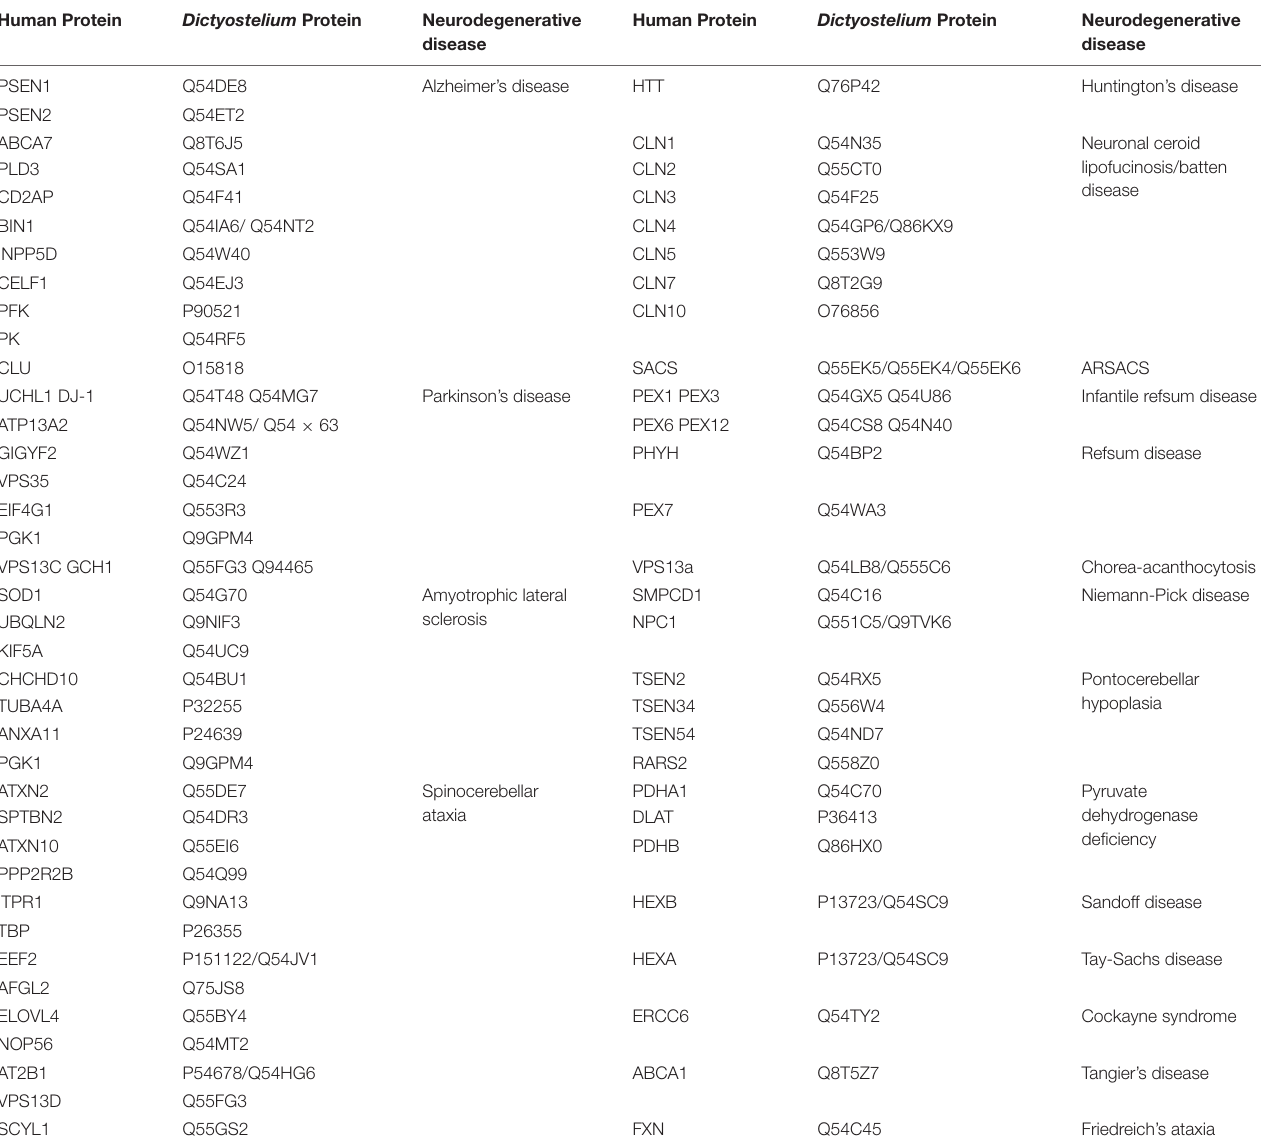
TABLE 1 | Human neurodegenerative disease proteins and their Dictyostelium homologs. Human